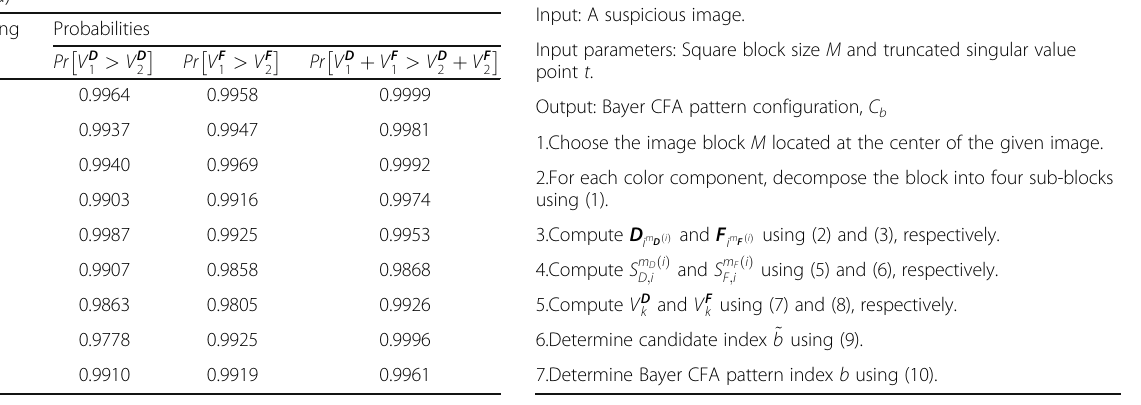
> V D > V F > V D , V F , and V D þ V F 1 2 1 2 1 1 2 Table 3 Overall algorithm for proposed